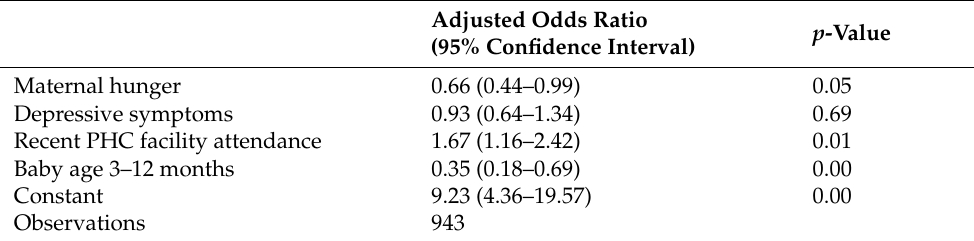
Table 3. Logistic regression of correlates of breastfeeding